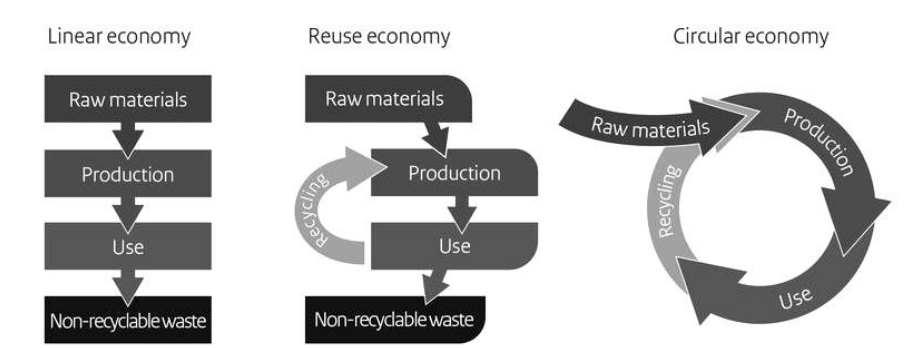
Fig. 2. From a linear to a circular economy (Government of the Netherlands, n.